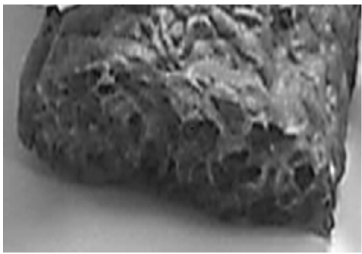
Figure 4. Photograph of the SBP composite foam.